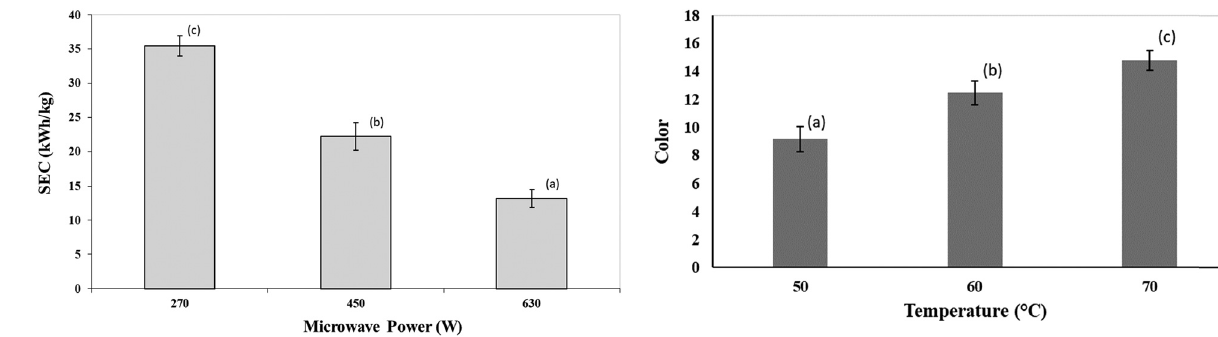
Figure 7: Values of SEC in MW for di ff erent microwave powers. The bars represent mean values and the corresponding standard deviations. Bars with the same letter are not signi fi cantly di ff erent according to ANOVA and Tukey test ( p < 0.05 ) .